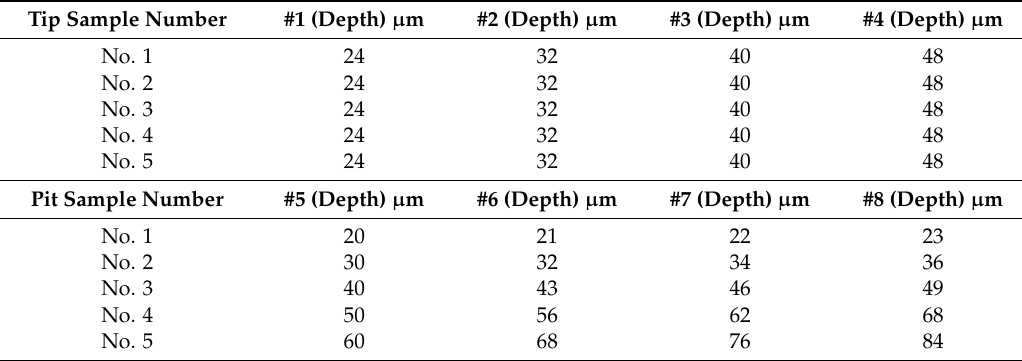
Table 2. The design table of four kinds of depth of tips and